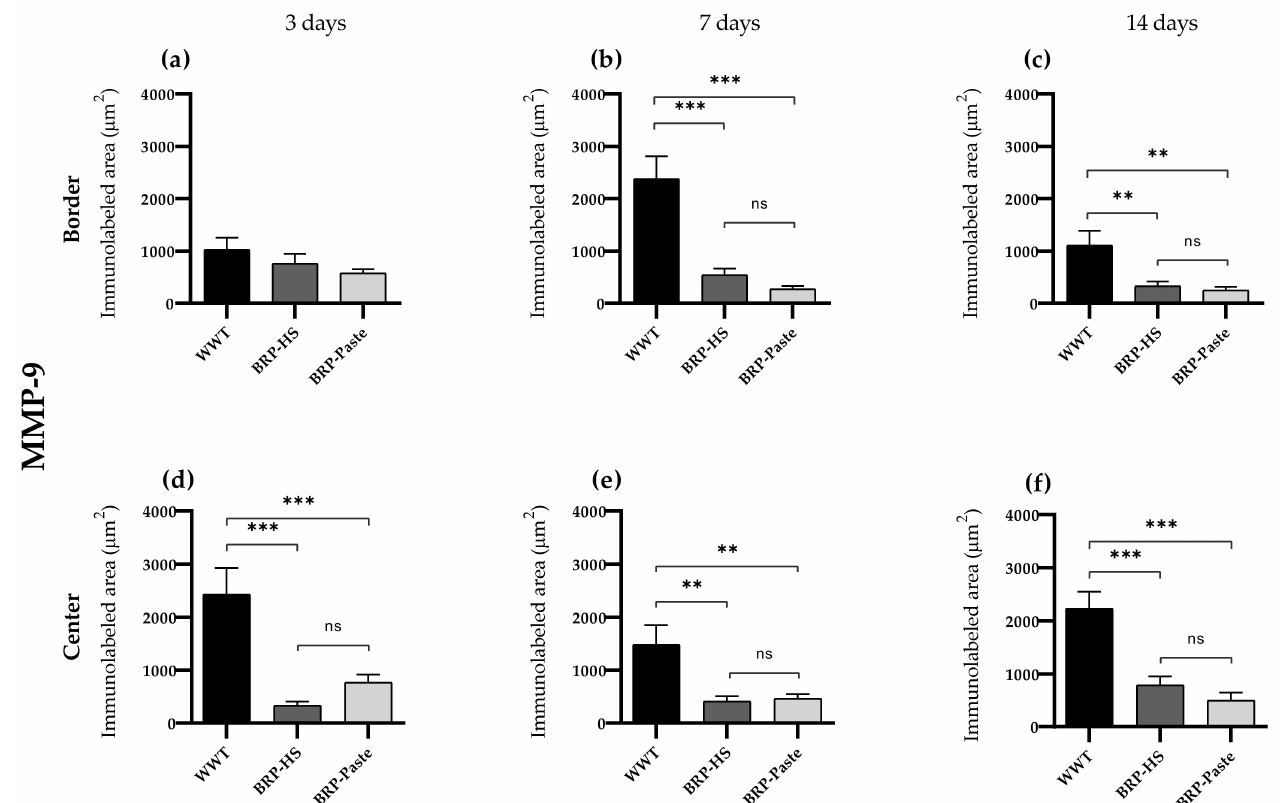
Figure 8. Quantification of the MMP-9 by immunolabed area ( µ m 2 ) at border ( a – c ) and cen- tral ( d – f ) regions (dermis) of the wounds in each experimental group for the periods of 3 ( a , d ), 7 ( b , e ) and 14 ( c , f ) days of treatment. Statistical difference compared to the WWT group was obtained by one-way ANOVA followed by Newman-Keuls test in which ** p < 0.01, and *** p < 0.001 ( n = 6). ns = no